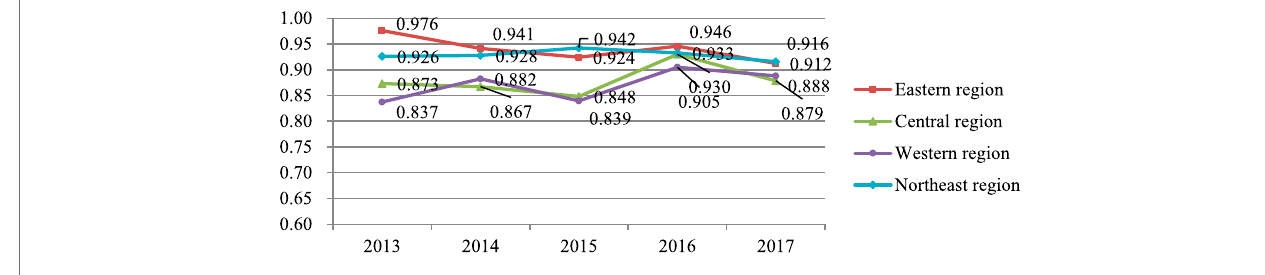
FIGURE 8 | CO 2 emission reduction ef fi ciency in various regions by year.